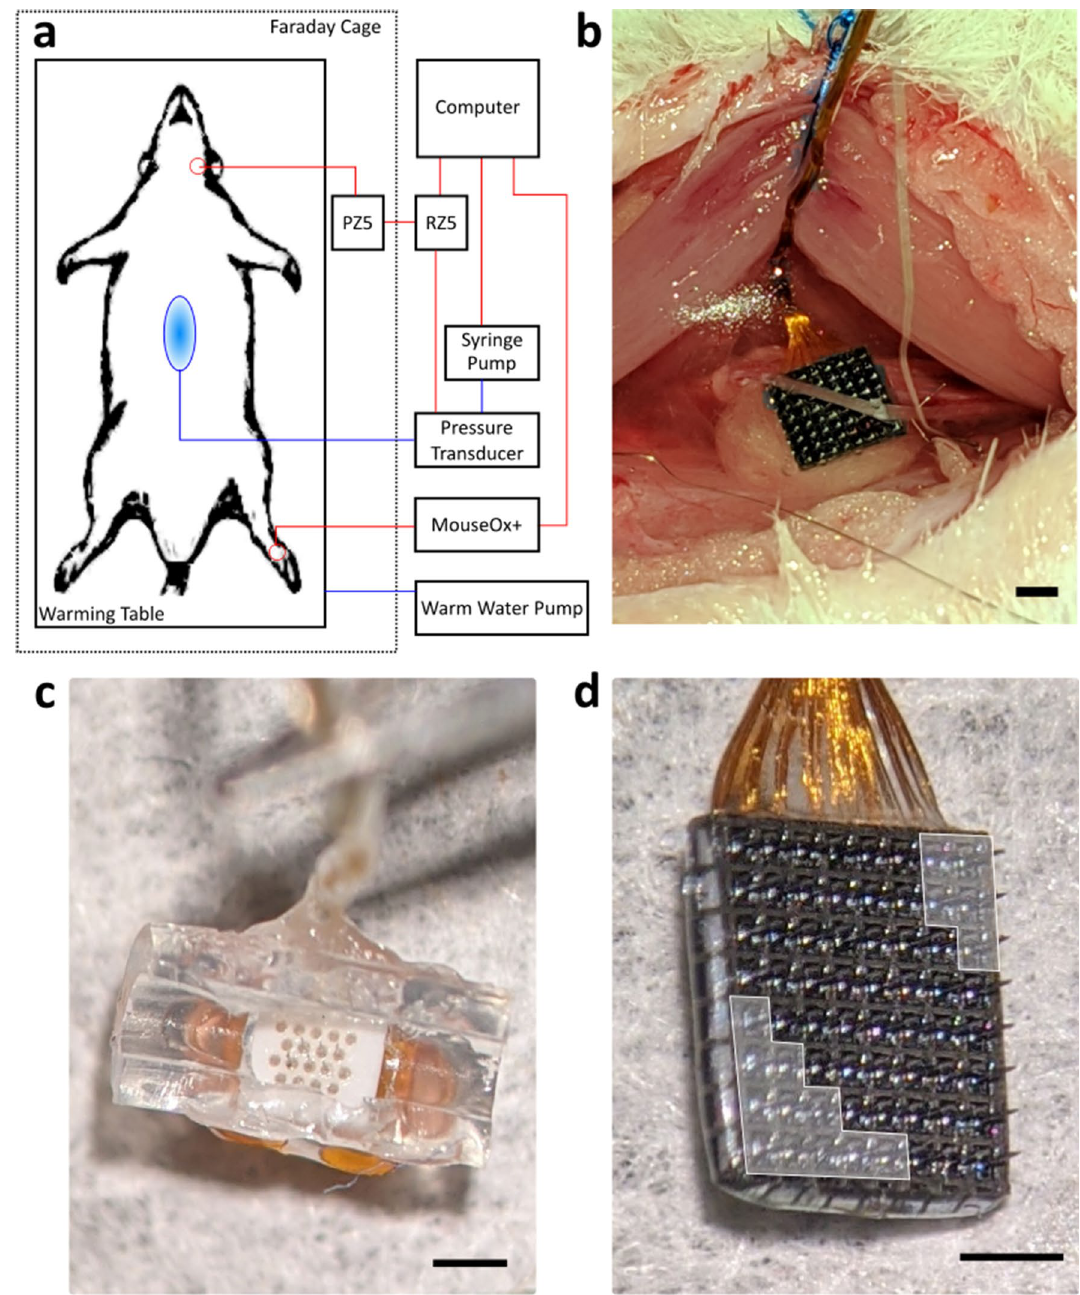
Figure 1. ( a ) Schematic of the experimental setup. Blue lines contain water. The blue oval represents the implanted balloon. Red lines are data lines. The red circle in the cervical area is the target implant site of the MEA. The red circle on the hind paw was the target site of the infrared vitals-monitoring clip. ( b ) View of the cervical vagus nerve implanted with the Blackrock MEA. ( c ) Microprobes MEA. ( d ) Blackrock MEA. Note, that while the Blackrock array appears as a standard 8 × 8, 64-channel MEA, the electrodes in the array were wired to three different 16-channel headstages. Thus, the 8 × 8 array was divided into three 16-channel subarrays that were in a diagonal (bottom left to upper right) orientation and 16 additional channels within the 8 × 8 array (shaded white) were nonfunctional. For ( b ) to ( d ), the black bar is 1 cotton-tipped applicators. Because each diet had a unique color (standard was brown, LF-HC was yellow, HF-LC was green), the researchers were not blinded to the specific diet the animal had been kept on. Once the stomach was empty, a urodynamic balloon catheter (Laborie, 9 Fr) was inserted into the stomach. Stomach size varied but was always shorter than the length of the balloon. To prevent balloon inflation outside the stomach, the neck of the balloon was constricted with surgical tape. Additionally, the tape served as an anchor point for sutures. The stomach was sutured closed and the catheter affixed in place to ensure consistent balloon positioning. Finally,